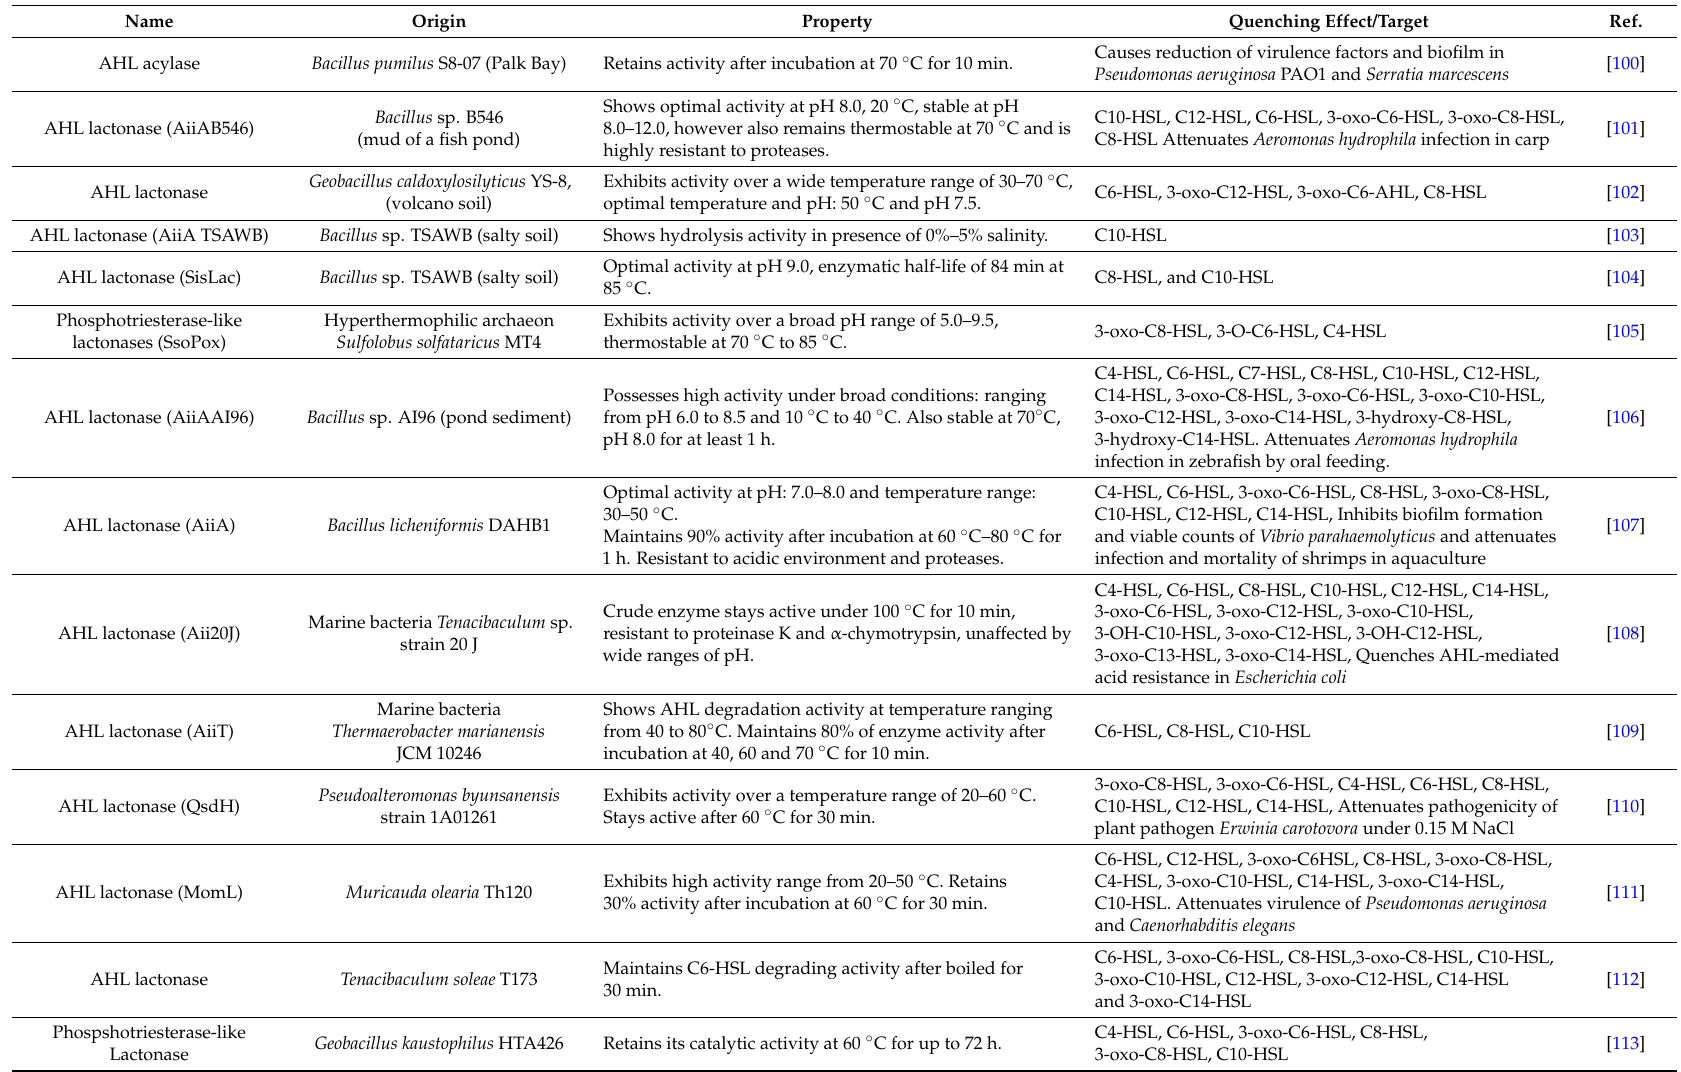
Table 5. List of AHL-lactonases and AHL-acylases that exhibit activity under thermophilic or saline